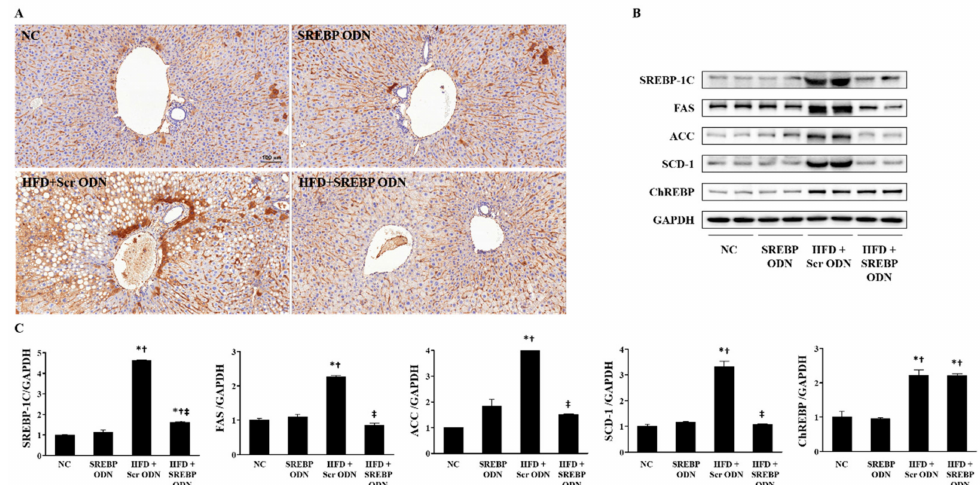
Figure 4. SREBP decoy ODN significantly inhibits cholesterol metabolism and fatty acid metabolism in the HFD-induced hyperlipidemic mouse model ( n = 6). ( A ) Immunohistochemical staining results show that SREBP decoy ODN inhibits expression of HMGCR. ( B ) Western blot results show that SREBP decoy ODN inhibits expression of SREBP-1c, FAS, ACC, SCD-1. ( C ) The expression levels of the protein from quantification of these images by Image J. Representative images from each group. Scale bar = 100 µ m. NC, normal control group; SREBP ODN, group treated with SREBP decoy ODN; HFD + Scr ODN, HFD fed group treated with scrambled decoy ODN; HFD + SREBP ODN, HFD fed group treated with SREBP decoy ODN. * p < 0.05 compared to the NC group. † p < 0.05 compared to the SREBP ODN group. ‡ p < 0.05 compared to the HFD + Scr ODN